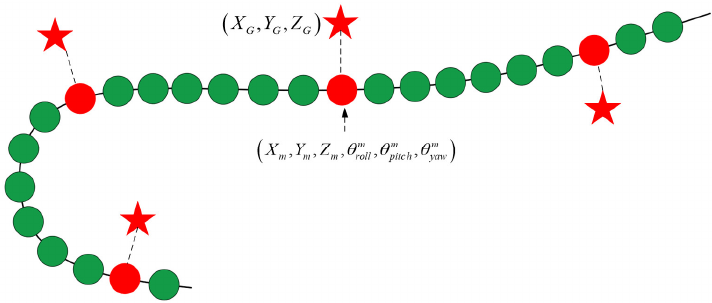
Figure 11. Principle of map optimization based on GNSS information. According to Equation (10), the covariance matrix Σ ri of the point cloud position for each current frame can be obtained. After substituting Σ ri and the covariance matrix of the current GNSS position data into Equation (11), the position of the robot can be obtained after integrating the data from the beginning to the present. A is the Point cloud pose and GNSS position data integration accuracy estimation matrix.